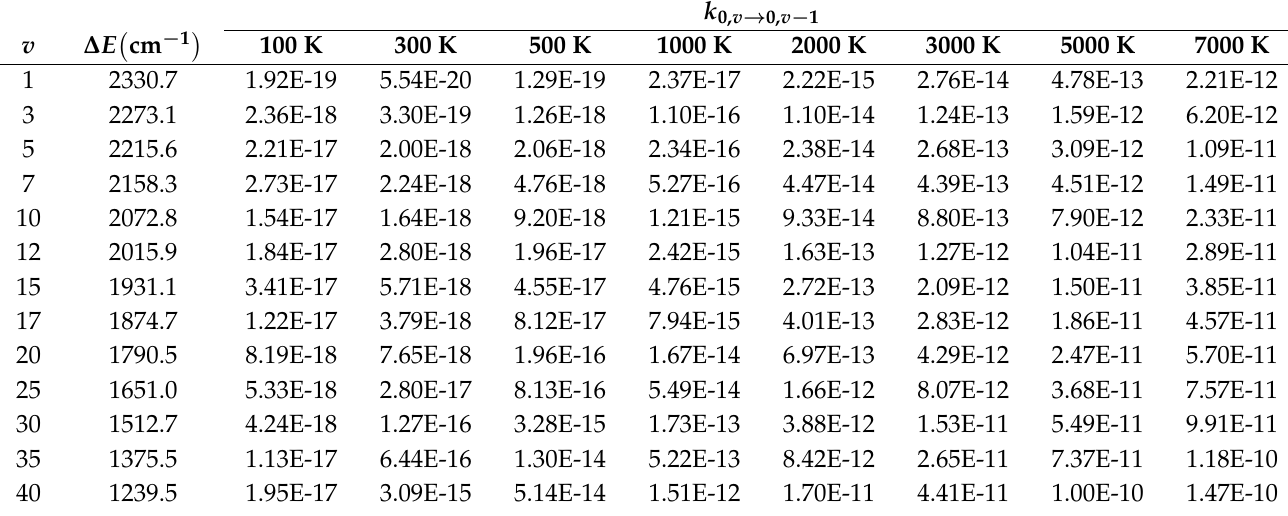
Table 9. Single quantum V–T/R rate coefficients (in cm 3 /s) for the transition CO ( 0 ) + N 2 ( v ) → CO ( 0 ) + N 2 ( v − 1 ) + ∆ E